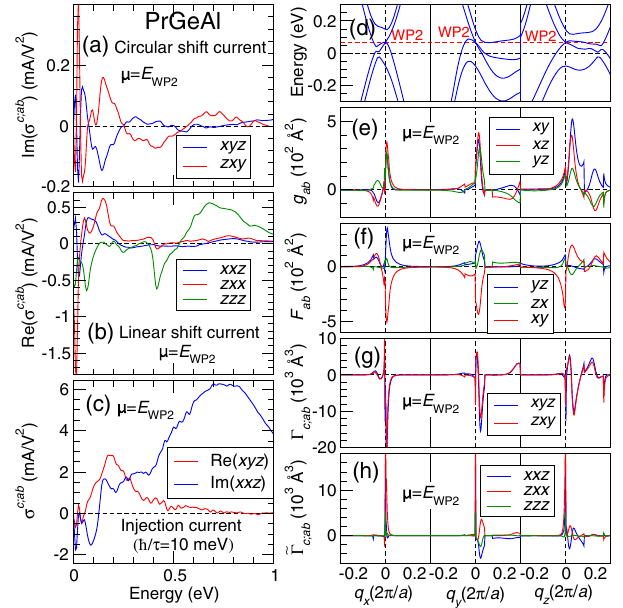
FIG. 8. Same as in Fig. 6, but with μ ¼ E (c) injection conductivity tensors. (d) Energy bands, (e) quantum metric g , (f) Berry curvature F ab and (h) symplectic Christoffel symbol Cartesian coordinate axis directions through the WP2 E ¼ E . Here, q ¼ k − k WP 2 placement from the